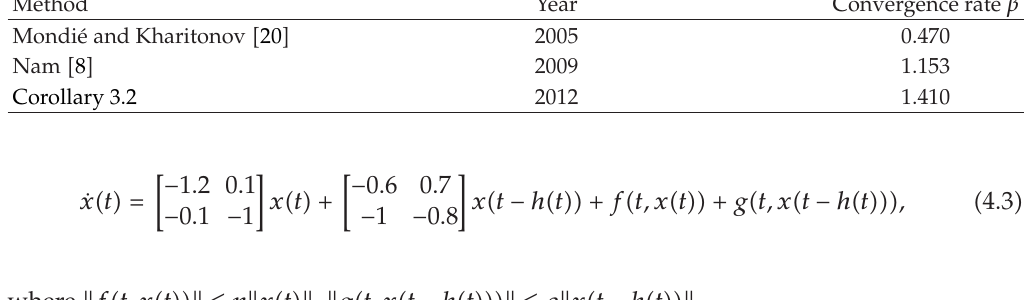
Table 3: Comparison of convergence rate obtained for Corollary 3.2 and from (cid:5) 8, 20 (cid:6) in Example 4.4. Method Year Convergence rate